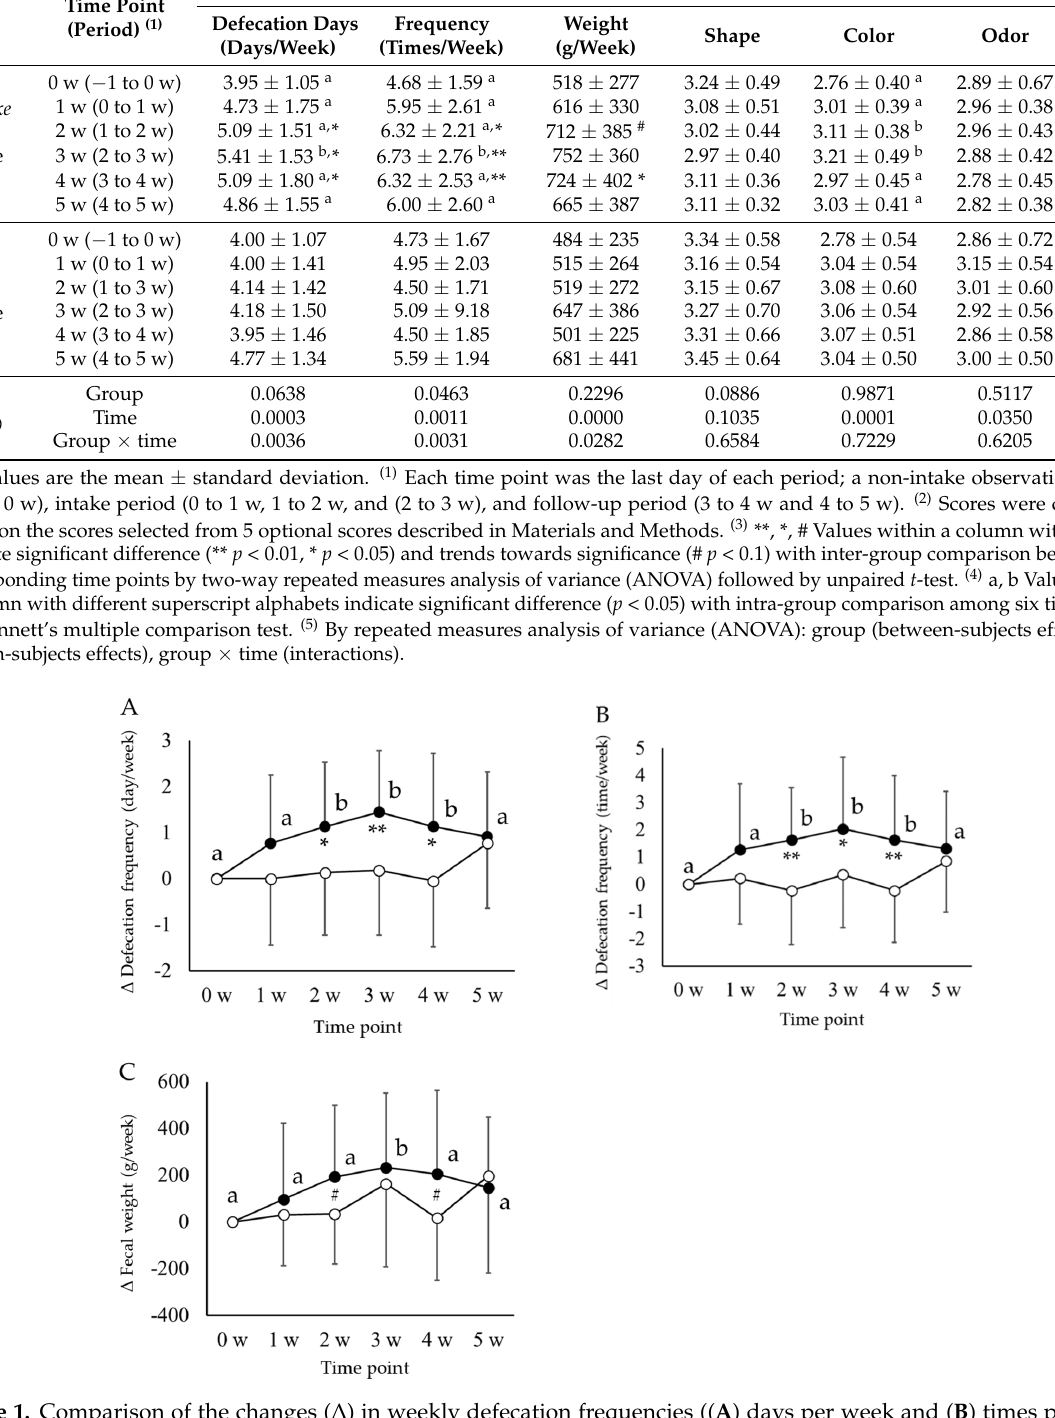
Figure 1. Comparison of the changes ( Δ ) in weekly defecation frequencies (( A ) days per week and ( B ) times per week) and fecal weight (( C ) g per week) from baseline values (0 w) in the koji amazake group (filled circle) and placebo group (empty circle). Each value is expressed as mean ± standard deviation. Inter-group comparisons between the koji amazake and placebo groups were performed using repeated measures analysis of variance (ANOVA) followed by a paired t − test; significant differences are indicated by ** p < 0.01, * p < 0.05, and # p < 0.1. a, b Intra-group changes from baseline values (0 w) in each group at six time points were compared using Dunnett’s multiple comparisons test; values with different superscript letters in each profile indicate significant difference ( p < 0.05).